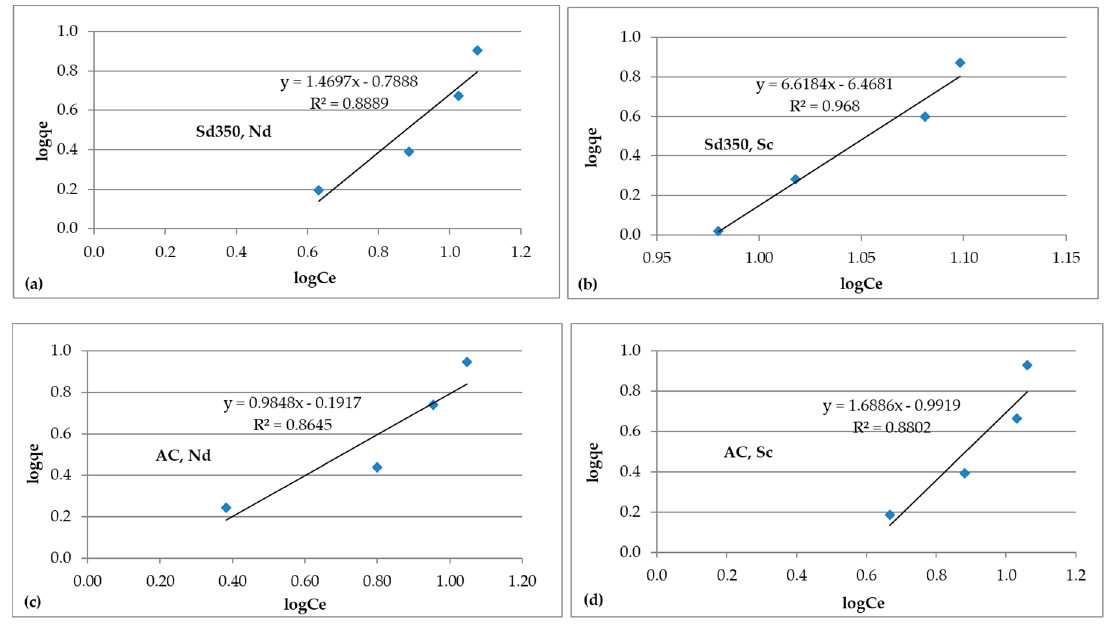
Figure 9. Freundlich isotherms for Nd and Sc adsorption on biochar Sd350 ( a,b ) and AC ( c,d ). Minerals 2017 , 7 , 200